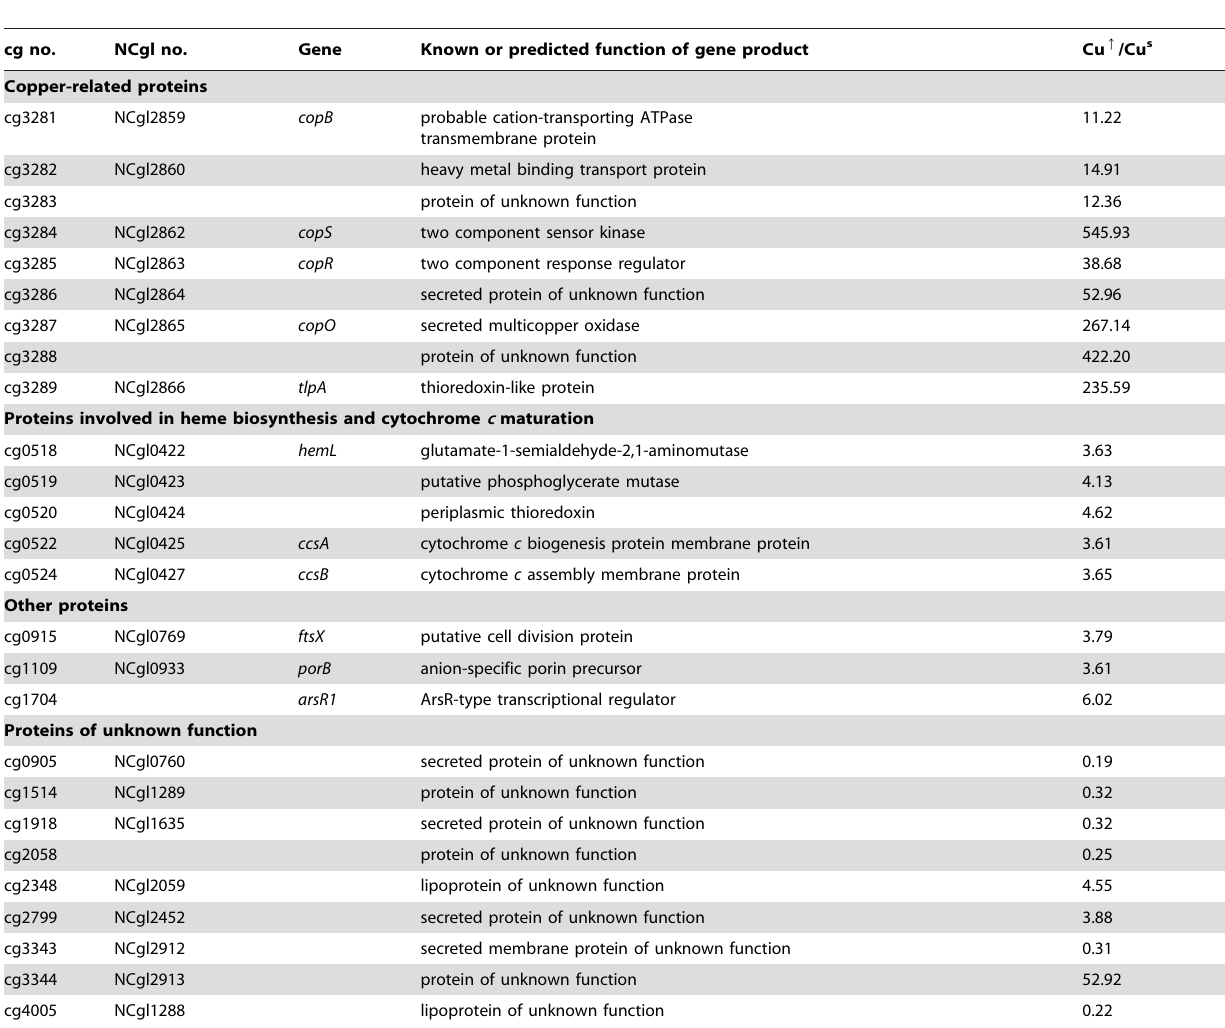
Table 1. Transcriptome comparison of C. glutamicum ATCC 13032 cultivated in CGXII minimal medium supplemented with 21.25 m M CuSO 4 (Cu q ) and in standard CGXII medium with 1.25 m M CuSO 4 (Cu s ) using DNA microarrays.